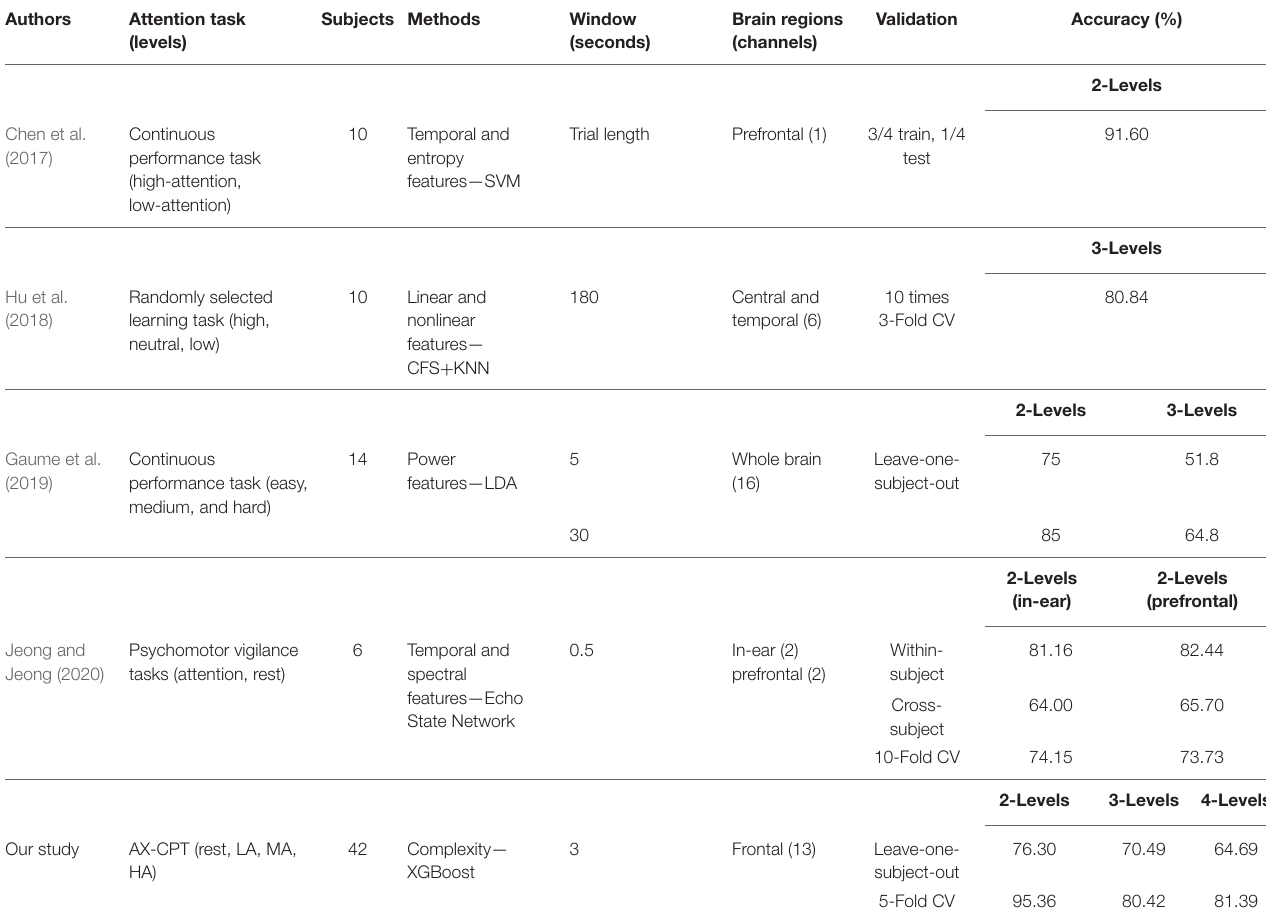
TABLE 3 | Comparison with previous studies on attention